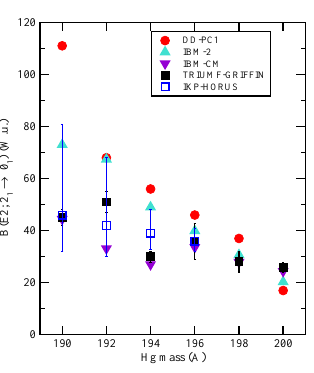
−→ 0 + Figure 4: B ( E 2; 2 + ) values (in Weisskopf units) 1 1 calculated using the 5DCH model with the DD-PC1 func- tional. Theoretical calculations with the IBM-2 [40], and IBM-CM [41] are given for comparison. Experimental values marked as TRIUMF-GRIFFIN are from Ref.